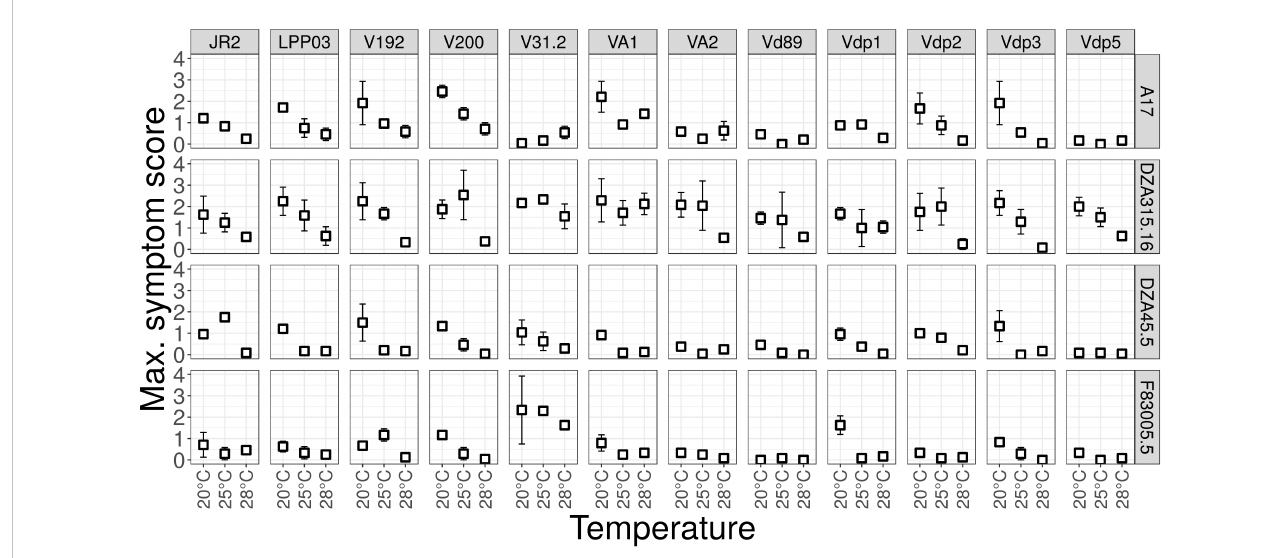
FIGURE 2 Aggressiveness of Verticillium strains on M. truncatula at different temperatures, shown by maximum symptom scores. Four M. truncatula lines (A17, DZA315.16, DZA45.5 and F83005.5) were root-inoculated with a spore suspension of the 12 Verticillium strains, and maintained at 20°C, 25°C and 28°C for four weeks. Symptoms were scored regularly on a scale from 0 to 4 and Maximum Symptom Scores (MSS) and Area Under the Disease Progress Curve (AUDPC, not shown) were determined at the end of the experiment. The values are means from three independent experiments, with eight plants each. Bars indicate standard error of observed